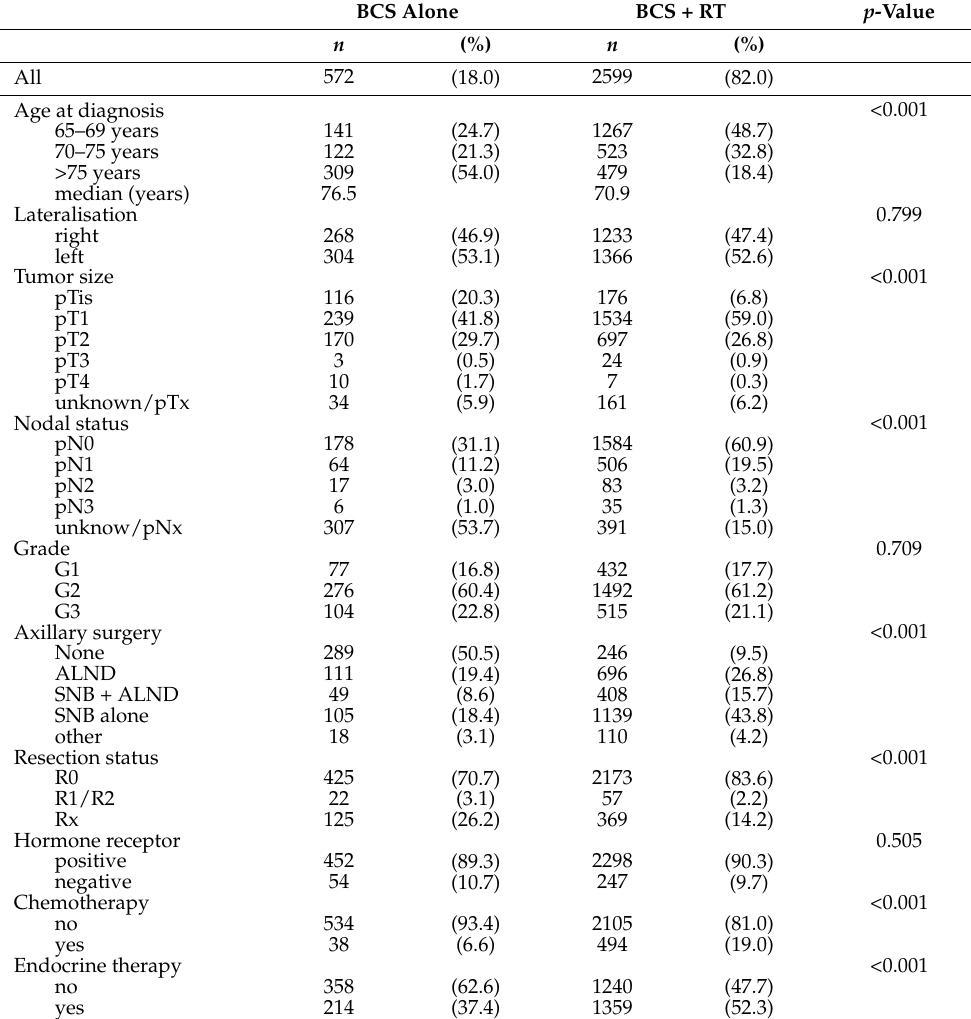
Table 1. Patient and tumor characteristics for the entire cohort. BCS: breast-conserving surgery; RT: radiation therapy; ALND: axillary lymph node dissection; SNB: sentinel node biopsy. BCS Alone BCS + RT p